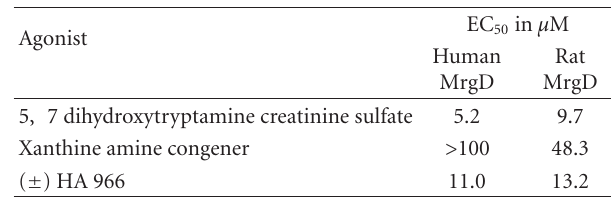
Table 2: Compounds exhibiting agonism at the MrgD receptor and not the parental CHO-DUKX